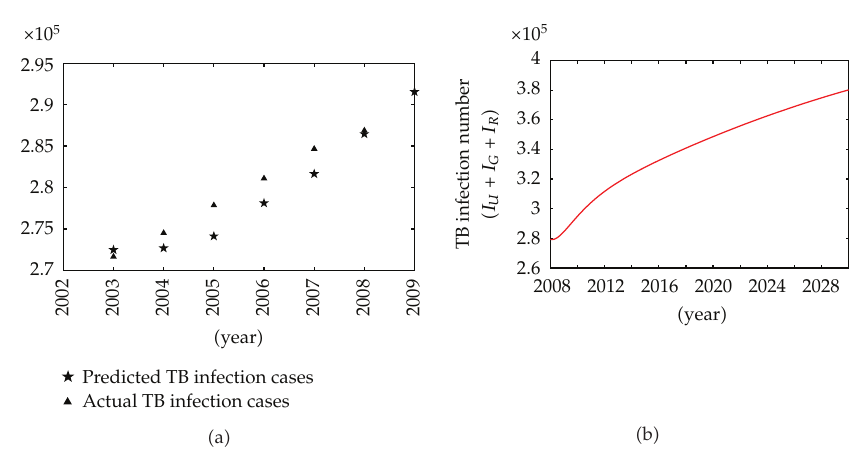
Figure 2: Trend simulation and prediction of the infection cases in Guangdong, China. (cid:2) a (cid:3) Contrast diagram of predicted TB infection cases and actual TB infection cases. (cid:2) b (cid:3) Prediction result of TB infection